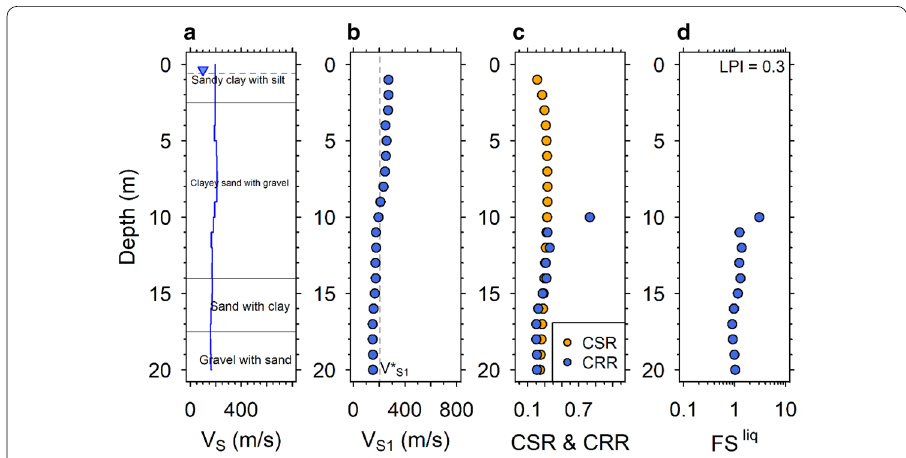
Fig. 7 Profiles of a raw V S measured by the downhole test; b V S 1 ; c CSR and CRR; and d FS liq at Site 5, where sand boils were not observed (non-liquefied site). The LPI is shown at the top right of ( d ). The clayey sand with gravel at a depth of 12 m has a fines content of